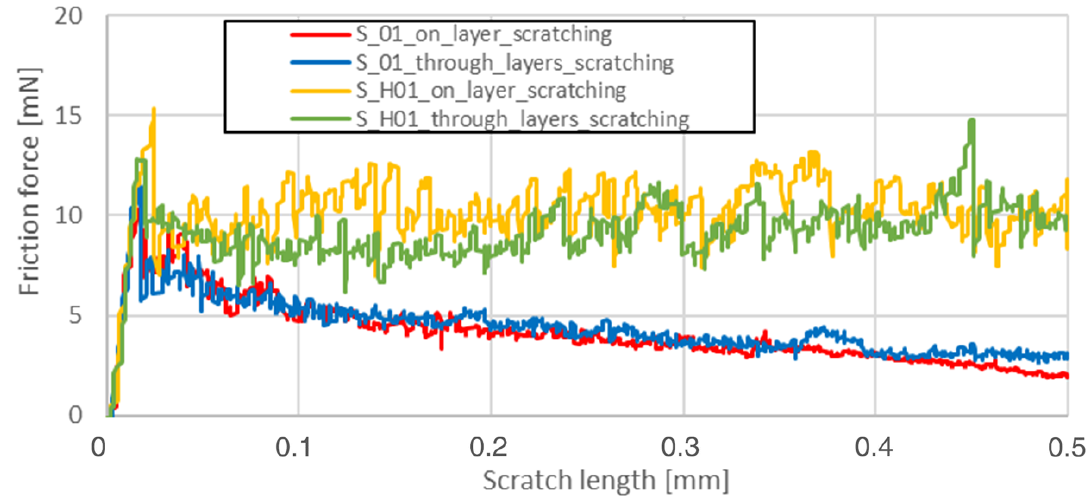
8 of 16 Figure 2. Residual stresses measured in two different directions of the samples after different types of processing (as build, underwent HIP, and precipitation annealed). 2.6. Friction Force and Sclerometric Hardness Measurement